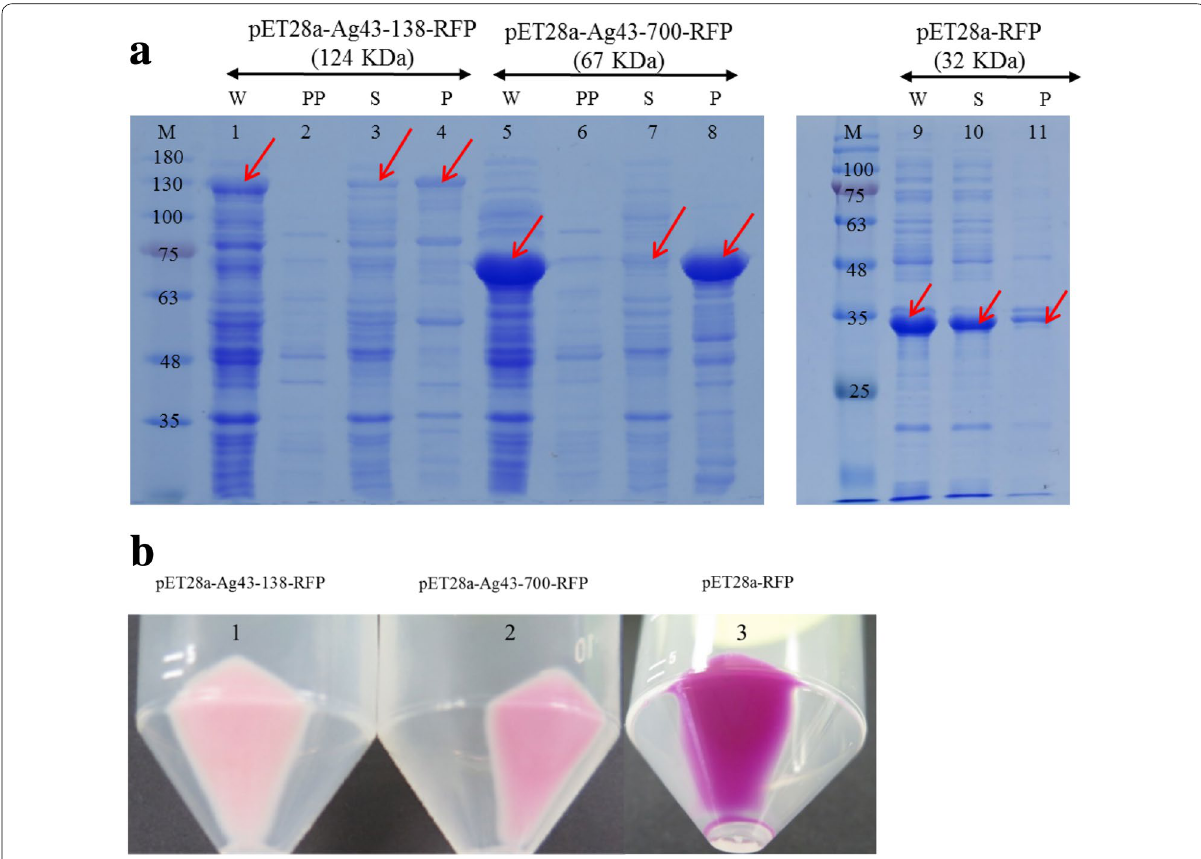
Fig. 5 a SDS‑PAGE analysis and cell pellets of recombinant RFP. pET28a‑Ag43‑138‑RFP (lanes 1–4), pET28a‑Ag43‑700‑RFP (lanes 5–8), and pET28a‑RFP (lanes 9–11) were analyzed by SDS‑PAGE. The red arrows indicate the recombinant proteins. M indicates a protein marker. W, PP, S, and P indicate whole cell, periplasm, supernatant, and pellet, respectively. b The performance of cell surface display for RFP. The cells carrying